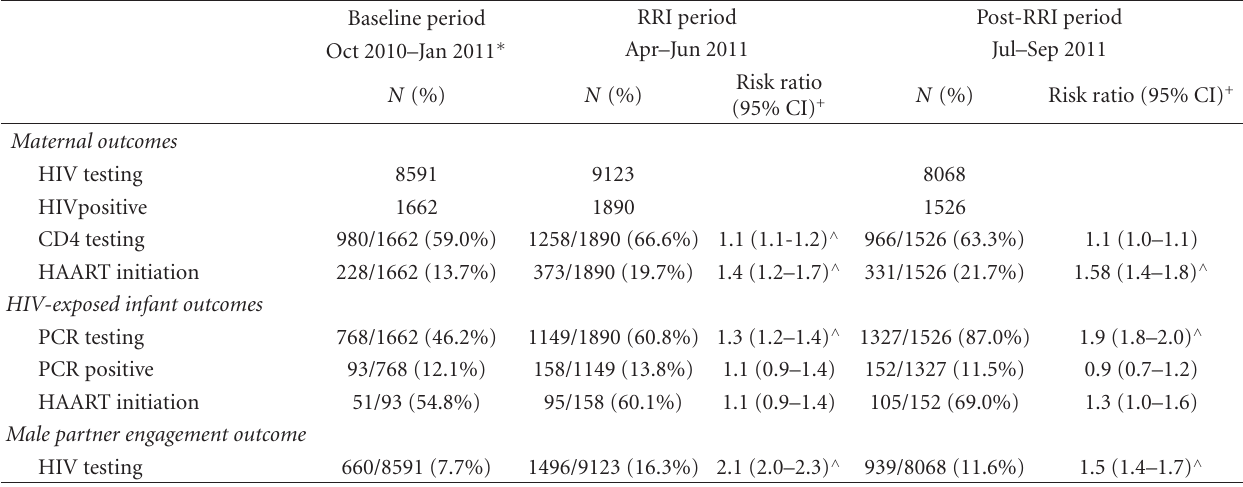
Table 1: Comparison of key PMTCT outcomes at baseline, and during the Rapid Results Initiative (RRI) and the post-RRI